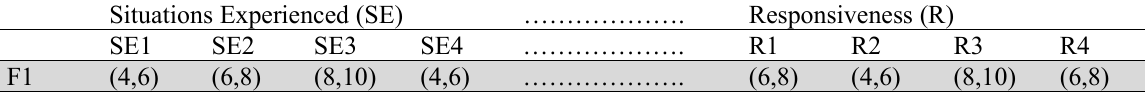
Also, the linguistic criteria importance weights obtained in Table 3 were assigned grey numbers as shown in Table 1 column 3. The result for Manager 1 is shown in Table 5. Table 5 Showing Converted Linguistic criteria importance weight Evaluations into grey numbers Situations Experienced (SE)